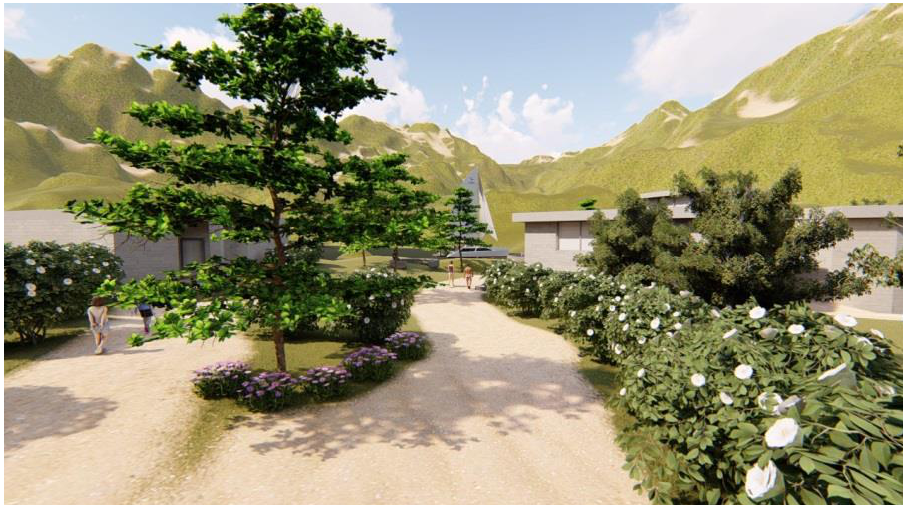
Figure 42. In a walk along the tourist settlement Lepenski Vir. Just like a walk in the park. Lepenski Vir, Serbia (2019) by ArhiArhi (Predrag, Vladimir and Grigor